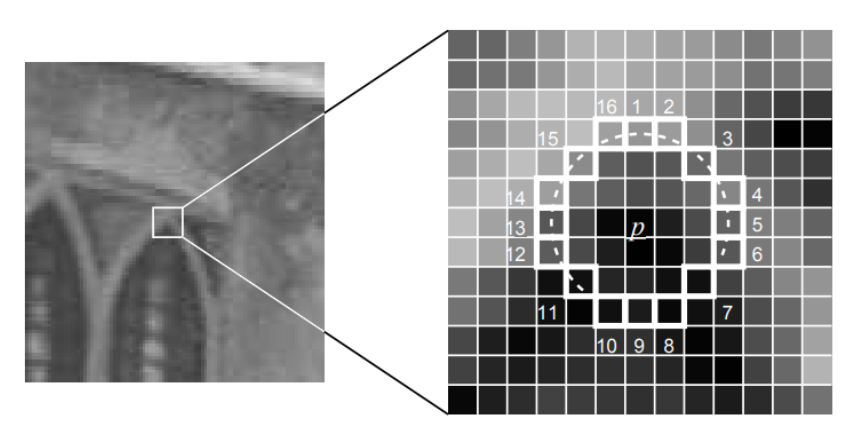
Figure 2. Twelve-point segment test corner detection in an image patch. The highlighted squares are the pixels used in the corner detection. The pixel at p is the centre of a candidate corner. The arc is indicated by the dashed line passing through 12 contiguous pixels which are brighter than p by more than the